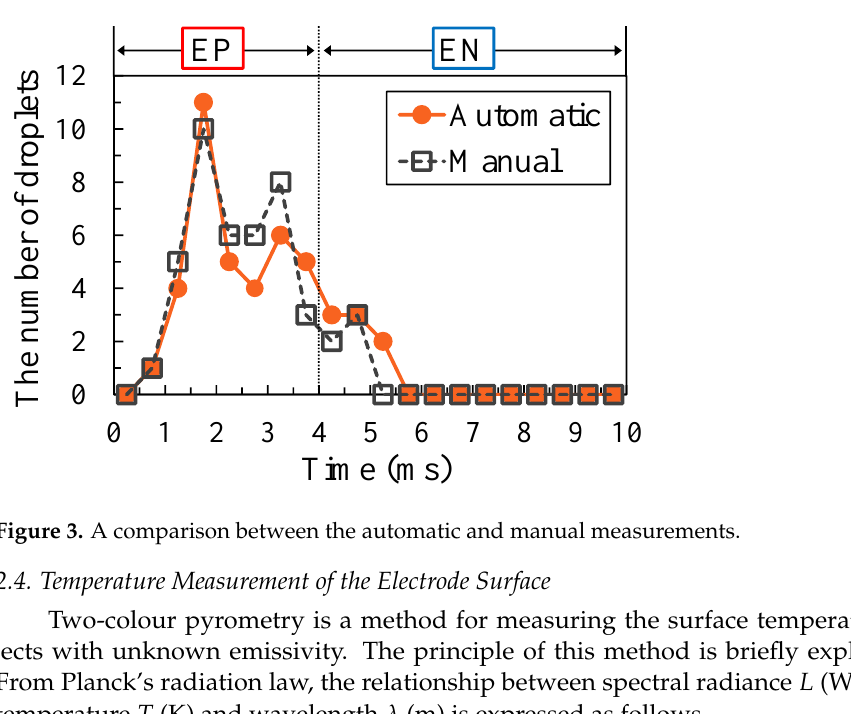
Figure 2. Image processing for the detection of droplet ejections: ( a ) original image of electrode’s appearance; ( b ) edge-detected and binarised image; and ( c ) superimposed image of binarised images for two consecutive frames.